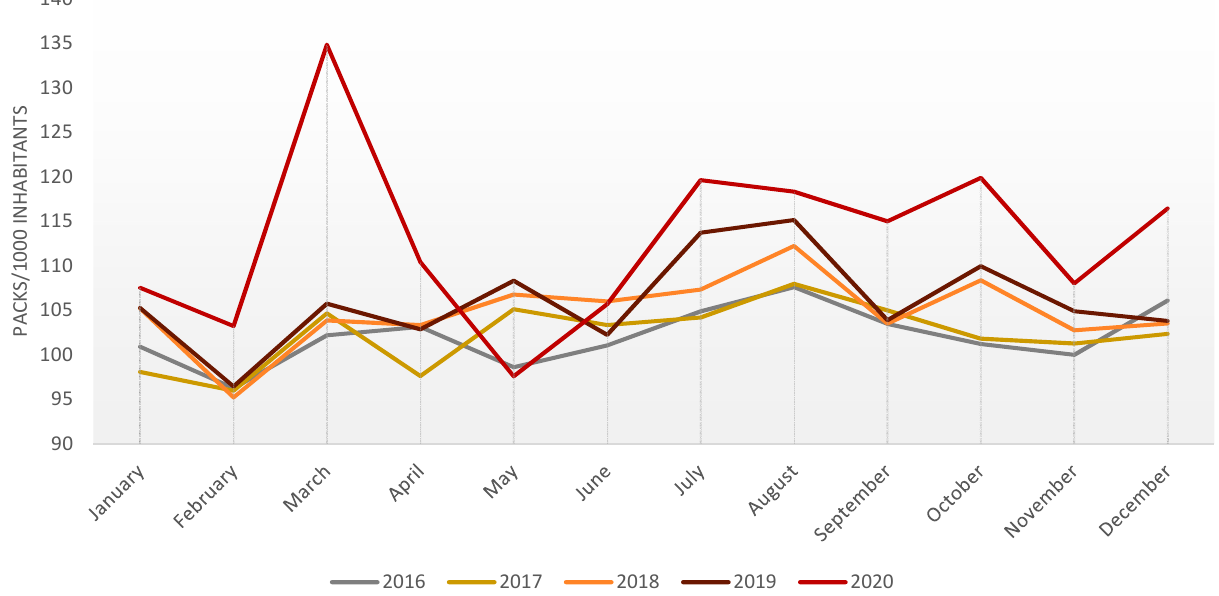
Figure 2. Monthly progression of the consumption of anxiolytics 2016–2020. If we study the statistical relation between the number of new COVID-19 cases in Castile and Leon each month [12] with the evolution of the monthly consumption of anxiolytics using SPSS, this results in a Pearson correlation coefficient of 0.133. The correlation coefficient ranges from − 1 (inverse relationship) to 1 (direct relationship). Hence, a value of 0 or close to it implies no linear correlation between the variables, as in this case (Figure 3).